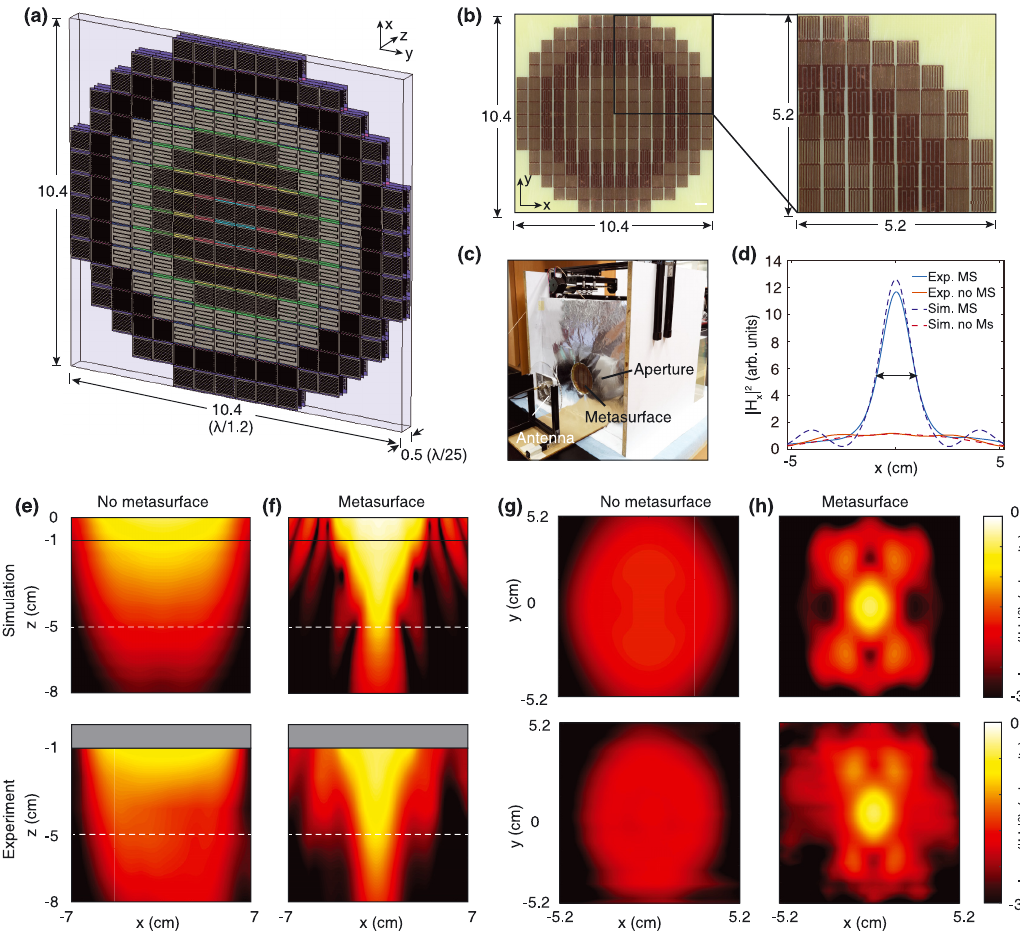
Figure 15: (Reprinted with permission from Ref. [22]). Antire fl ection focusing from air into 5 cm ( λ /2.5) depth in water. (a) A perspective view of the metasurface using eight unit cells distributed in a circular ring form. Cells occupying the same background color are identical. (b) A photograph of the fabricated metasurface: a quarter of the metasurface is enlarged on the right. (c) A photograph of the experimental setup. (d) The normalized magnetic fi eld intensity along the focusing depth with and without the metasurface (MS) from simulation(Sim.)andexperiment(Exp.).Thearrowindicatesthefullwidthathalfmaximum(FWHM)of0.16 λ .(e)and(f)Thesimulated(top)and measured (bottom) magnetic fi eld intensity at the x – z plane (e) without and (f) with the metasurface. (g) and (h) The simulated (top) and measured (bottom) magnetic fi eld intensity at the 5 cm-deep focal plane ( x – y plane) (g) without and (h) with the metasurface. The water is simulated with a complex relative permittivity ε 2 = 78 − 11.7